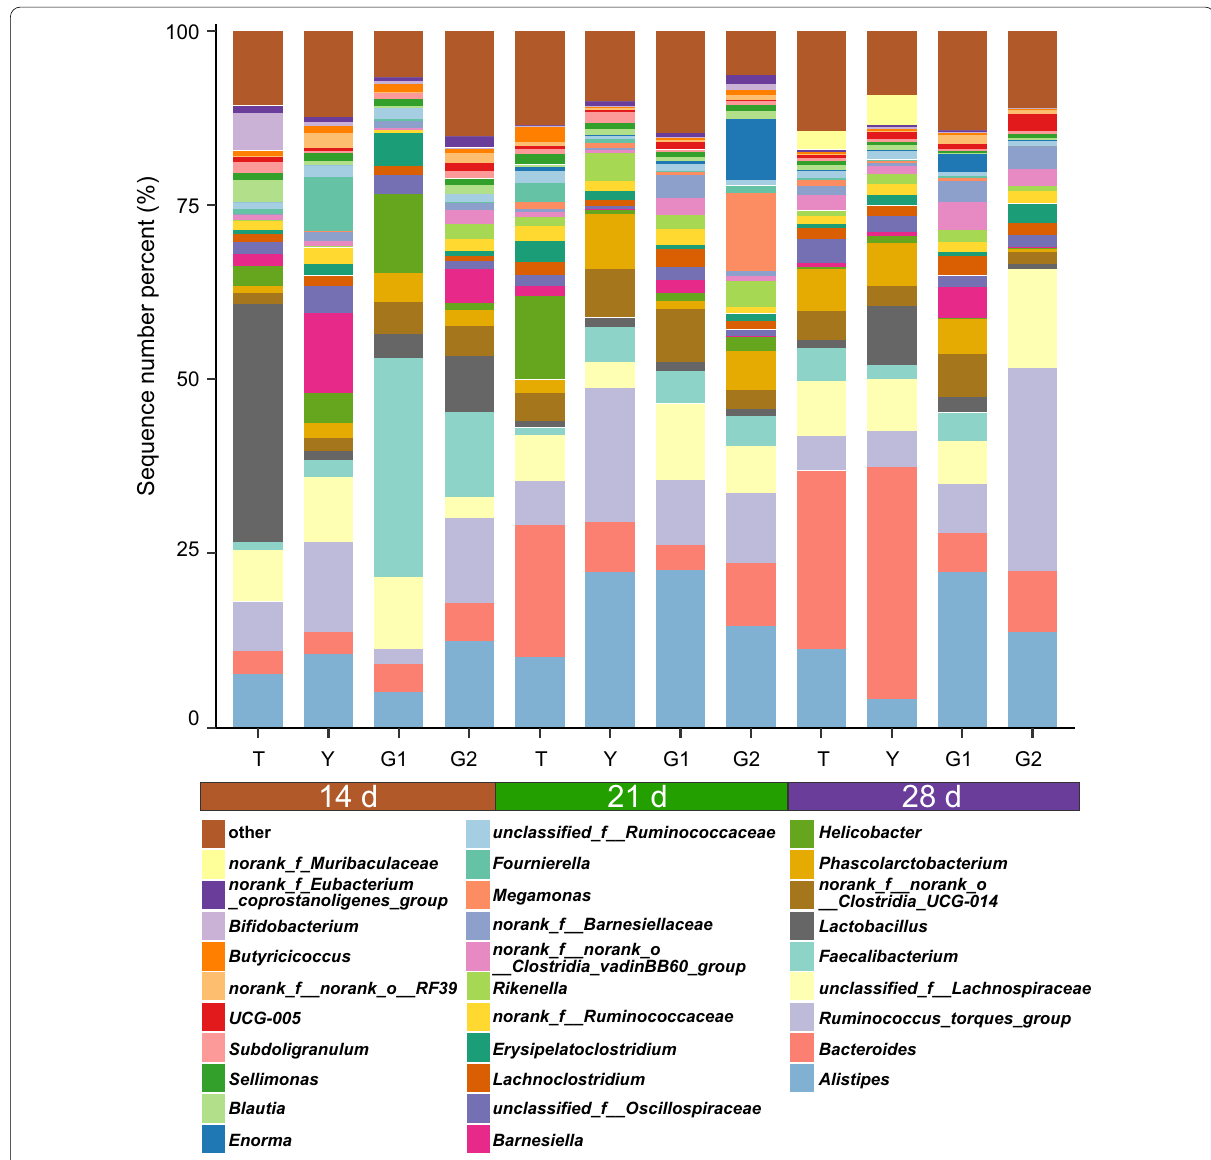
Fig. 7 The top 30 features in Y (control group), T (antibiotic group), G1 (0.1% β-1,3/1,6-glucan), and G2 (0.2% β-1,3/1,6-glucan) groups of cecum microbiome in broilers. Each color indicates the relative abundance of a bacterial taxon on the bar